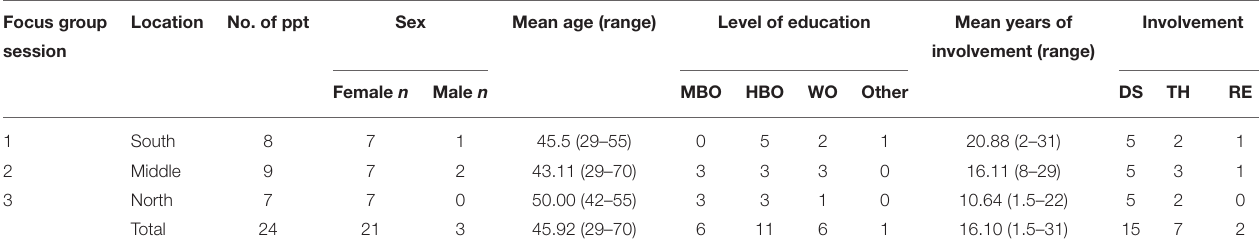
TABLE 2 | Description of the focus group participants. Focus group Location No. of ppt Sex Mean age (range) Level of education Mean years of